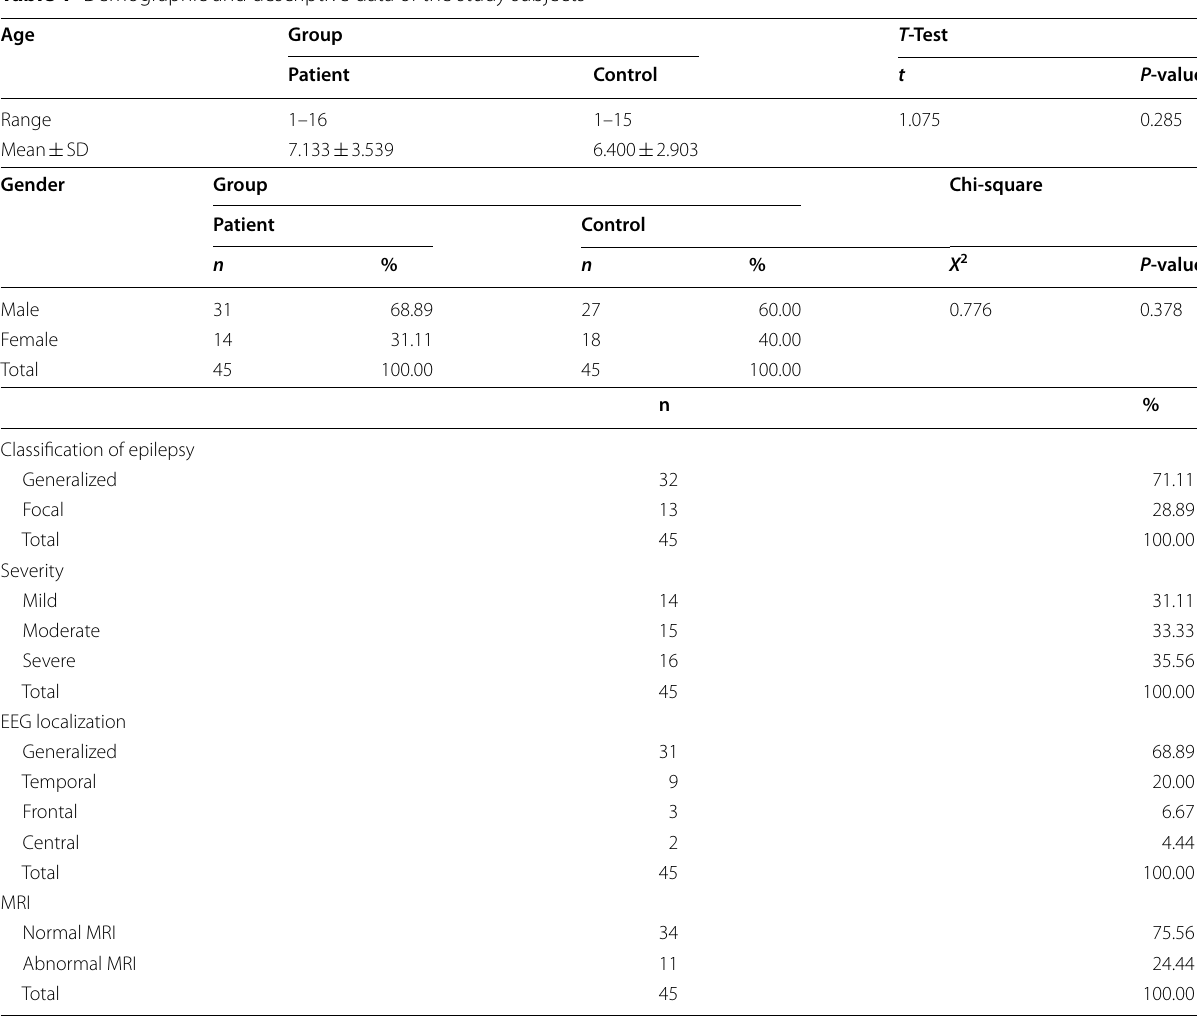
Table 1 Demographic and descriptive data of the study subjects